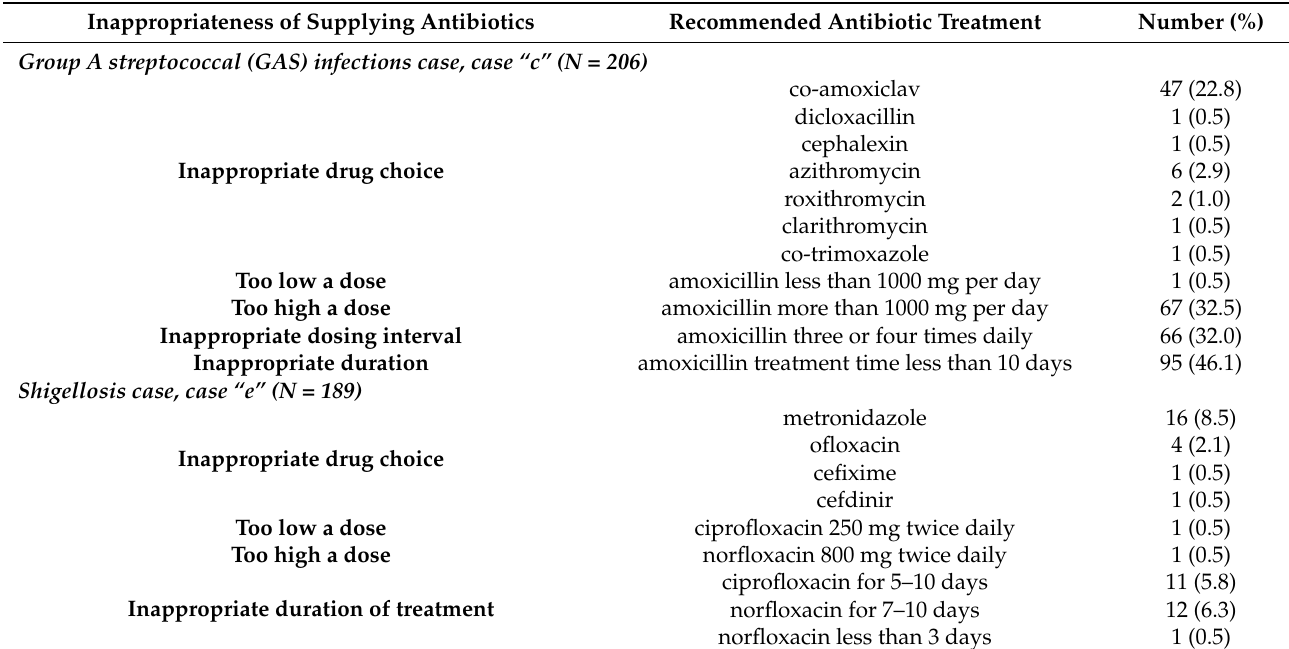
Table 3. Appropriateness of antibiotic treatment recommended by community